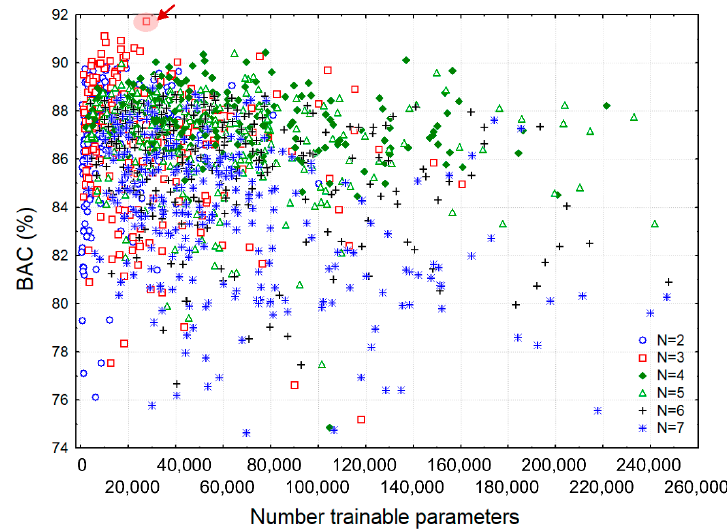
Figure 4. Validation BAC performance of all random search CNN models in function of the number of trainable parameters. The scatter plot is depicted in six groups for the number of convolutional blocks N = {2, 3, 4, 5, 6, 7}. The highlighted scatter point is corresponding to the best performance model CNN3-CC-ECG.